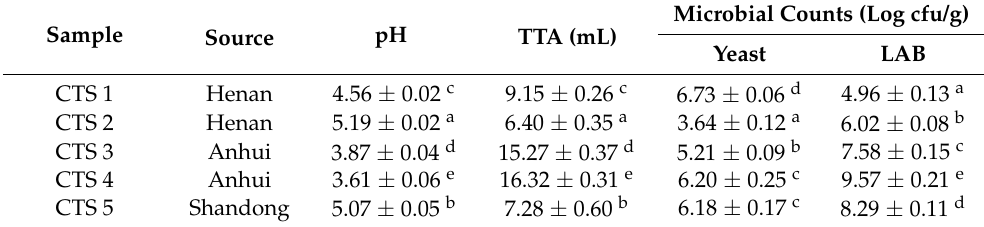
Table 1. Acidity and microbial counts of